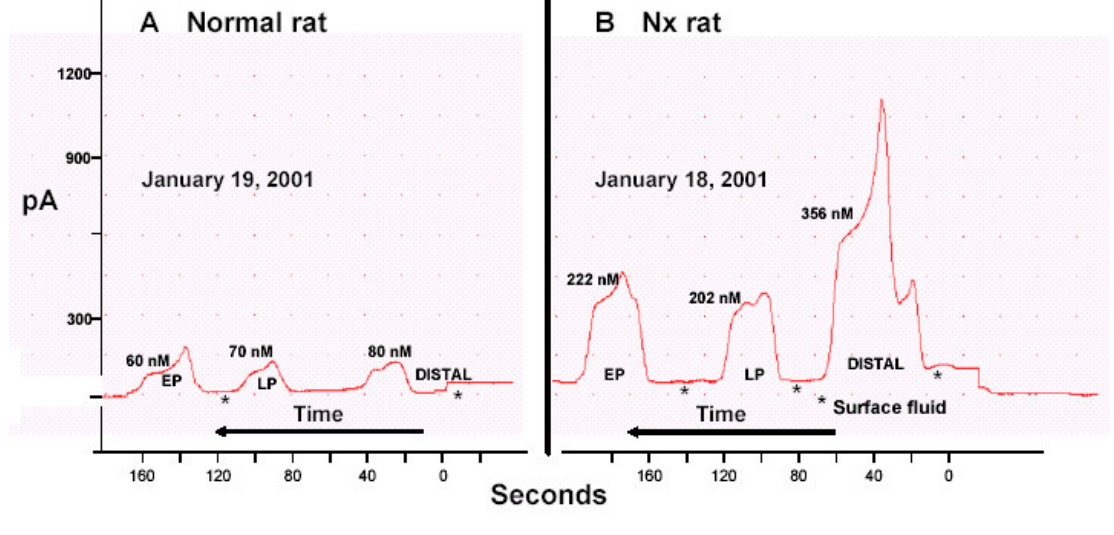
Figure 3 A, B. Intratubular recordings from normal and Nx rats using the same glass insulated electrode on successive days. A. Recording showing NO measurements from a distal, late proximal, and early proximal tubule from the same nephron of a normal rat kidney. The surface fluid (asterix ) is the zero point taken immediately before inserting the electrode into the nephron segment. The pA difference is taken from the surface fluid to the shoulder of the response. The time scale is compressed so that stable and more level shoulders are apparent in real time. B. Corresponding measurements from an Nx rat using the same electrode. See also